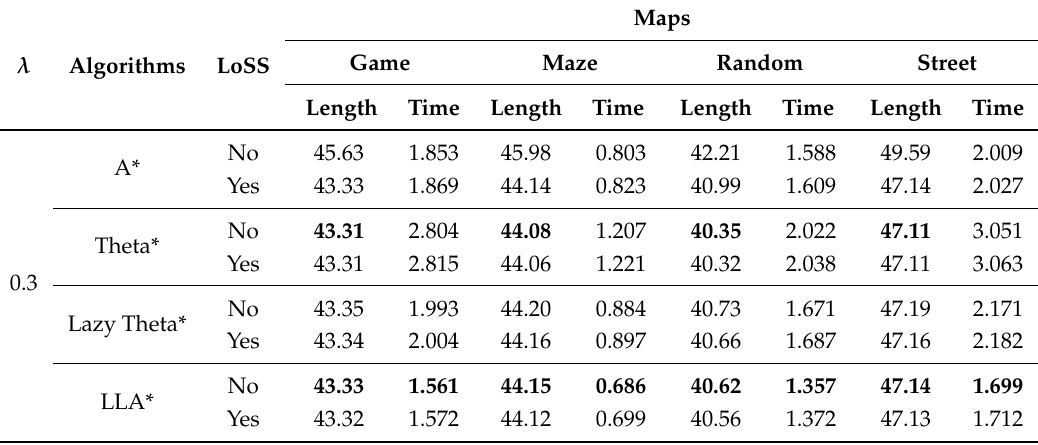
Table 1. Average path length and execution time (s) with/without LoSS